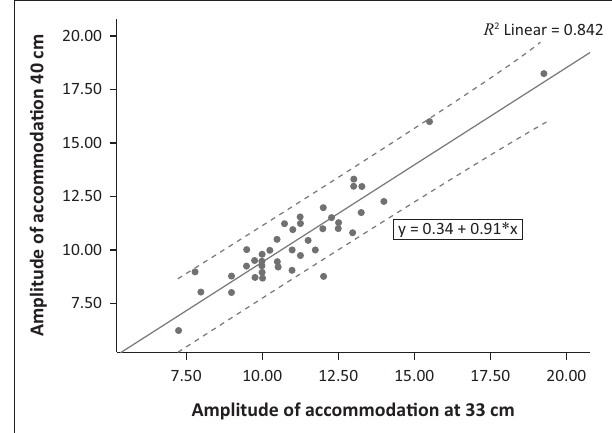
FIGURE 3: Linear regression of the amplitude of accommodation measured with the target at 33 cm against the amplitude of accommodation measured with the target at 6 m ( r = 0.60, p = 0.00).